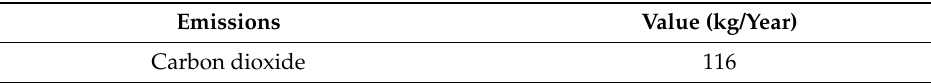
Table 13. The simulation results for the third case using iHOGA